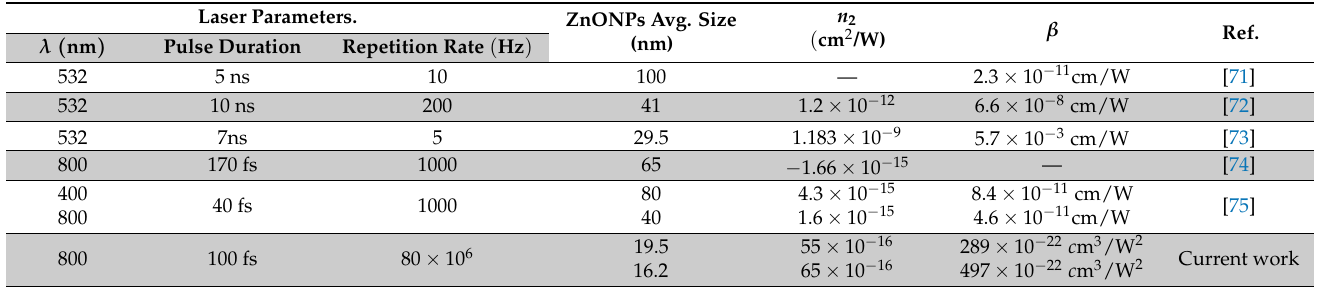
Table 1. Comparison of the nonlinear optical properties of ZnONPs obtained in previous studies and those obtained in this study.